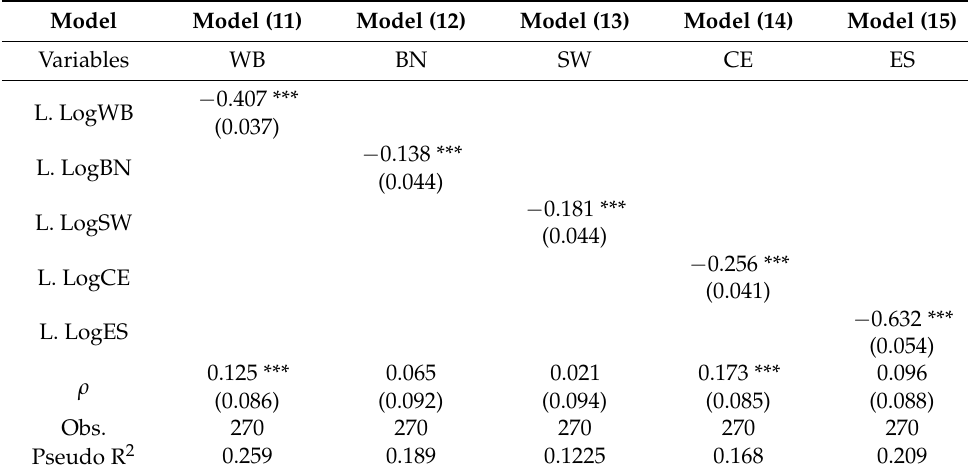
Table 4. Results of spatial conditional β convergence